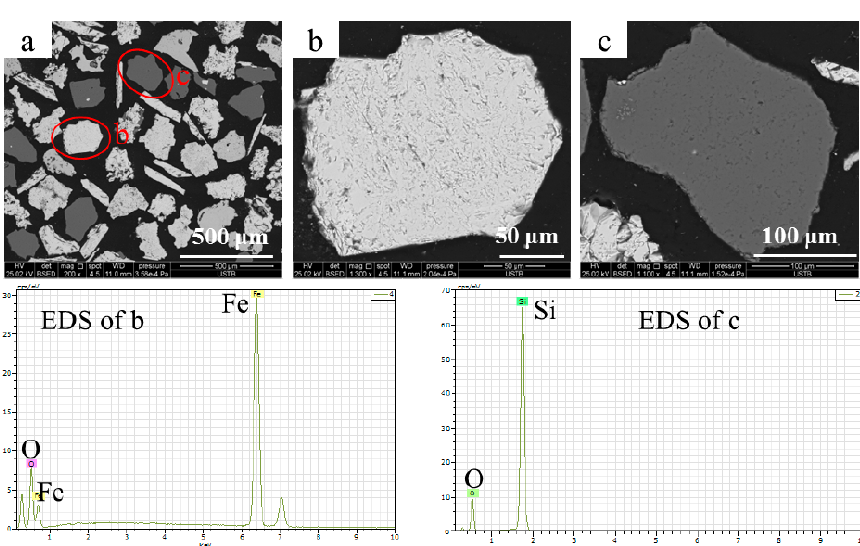
Figure 2. Cross section images and EDS results of the Brazilian iron ore particles: ( a ) Overview of the sample; ( b ) hematite particle in big magnification; ( c ) silica particle in big magnification.